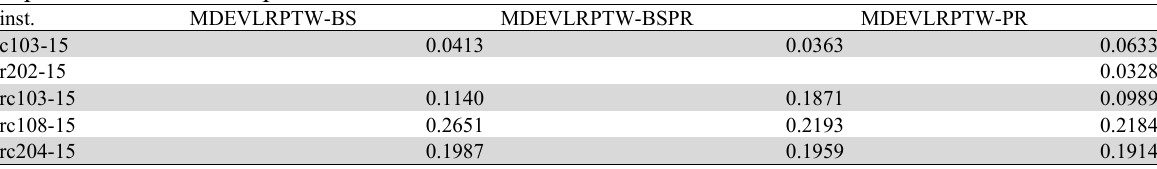
Gap values of the non-optimal instances